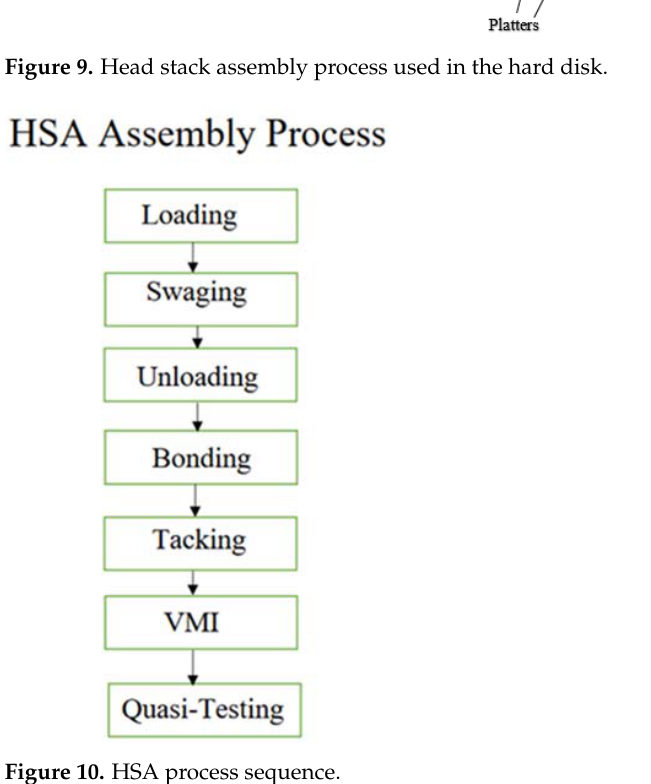
Figure 10. HSA process sequence.